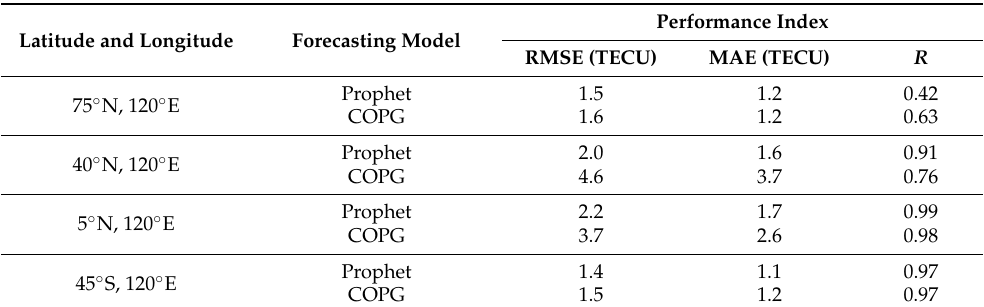
Table 3. Accuracy comparison of the Prophet and COPG models at different latitudes at longitude 120 ◦ E.